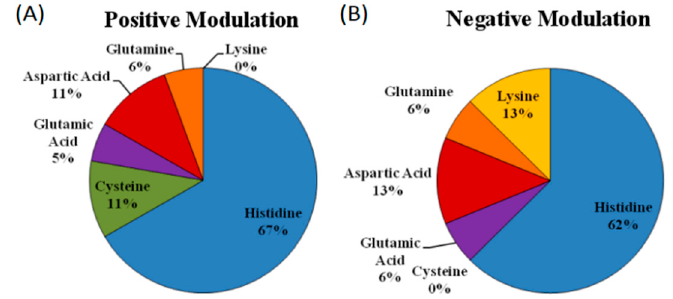
Figure 5. Comparison of zinc ligands in positively modulated vs. negatively modulated agonist-gated receptors. We examined 14 known receptor channels depicted in Table 1 and ascertained in these channels whether the same amino acids are part of the zinc coordination sphere in the case of positive ( A ) and negative ( B ) modulation zinc-responses. The results show that while His is the most prevalent zinc ligand in either type of allosteric modulation examined, Cys is only present in the positive modulation. No cysteines were found in the negatively zinc-modulated receptor channels. Interestingly, Lys is only a zinc ligand of the negatively zinc-modulated receptor channel, an amino acid that forms part of the zinc coordination shell which is not frequently encountered as a recognized zinc ligand.